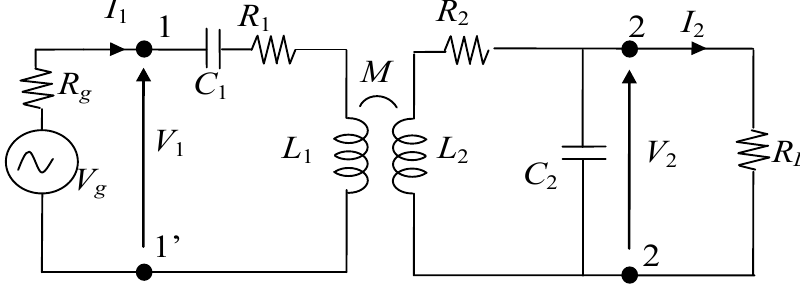
Figure 5. Simplified equivalent circuit of two coupled coils with SP compensation.